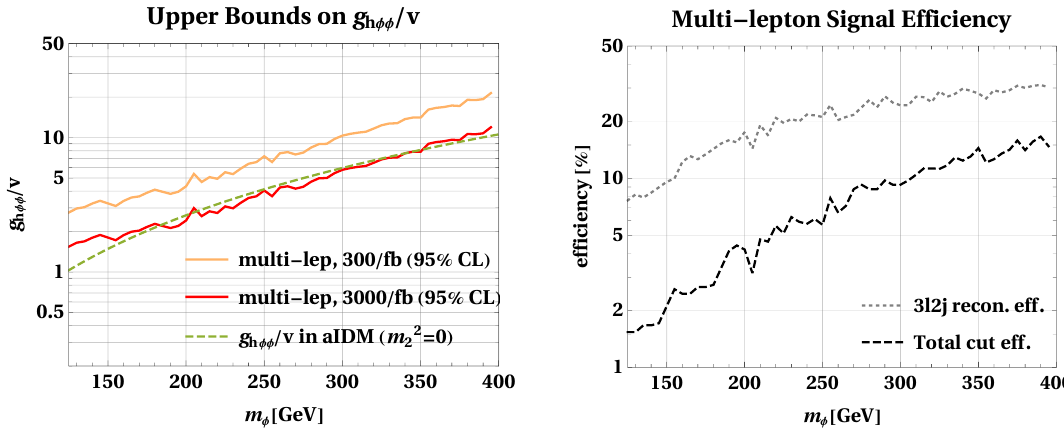
Figure 4. Left panel shows the upper limits on g h(cid:30)(cid:30) =v from pp ! h ! (cid:30)(cid:30) ! ( WW )( WW ) ! ( ‘(cid:23)‘(cid:23) )( ‘(cid:23)jj ) at the LHC with 300 fb (cid:0) 1 and HL-LHC (3000 fb (cid:0) 1 ). We also include the value of g h(cid:30)(cid:30) =v in aIDM for m 2 = 0, which is given by 4 m 2 =v 2 . Right panel shows the cut e(cid:14)ciency for 2 (cid:30) the